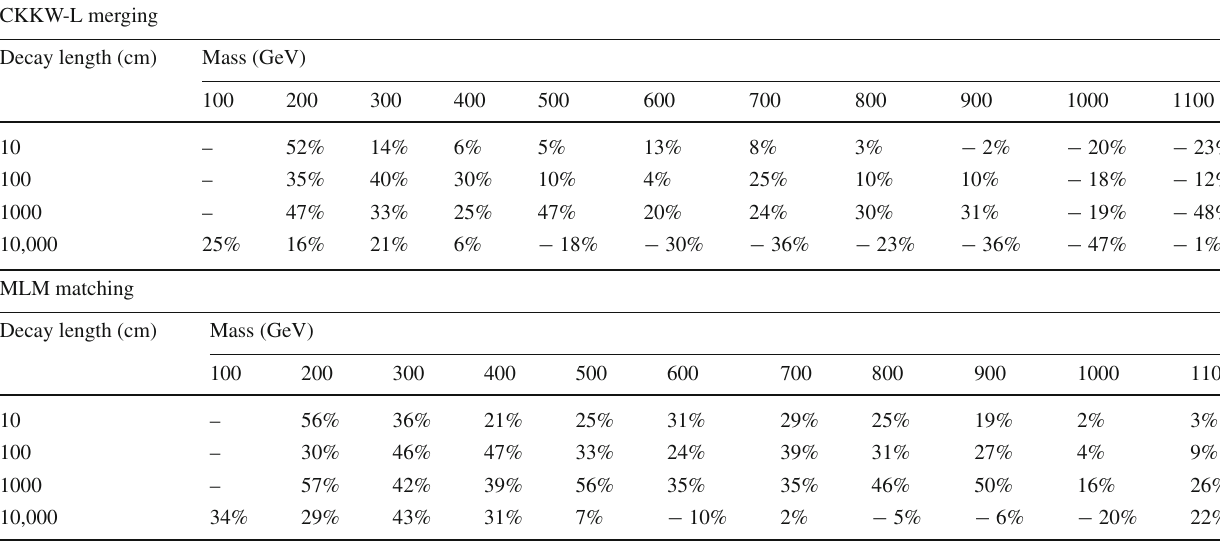
Table 4 Errors for chargino-neutralino events. Top: using CKKW-L merging; Bottom: using MLM matching CKKW-L merging Decay length (cm)